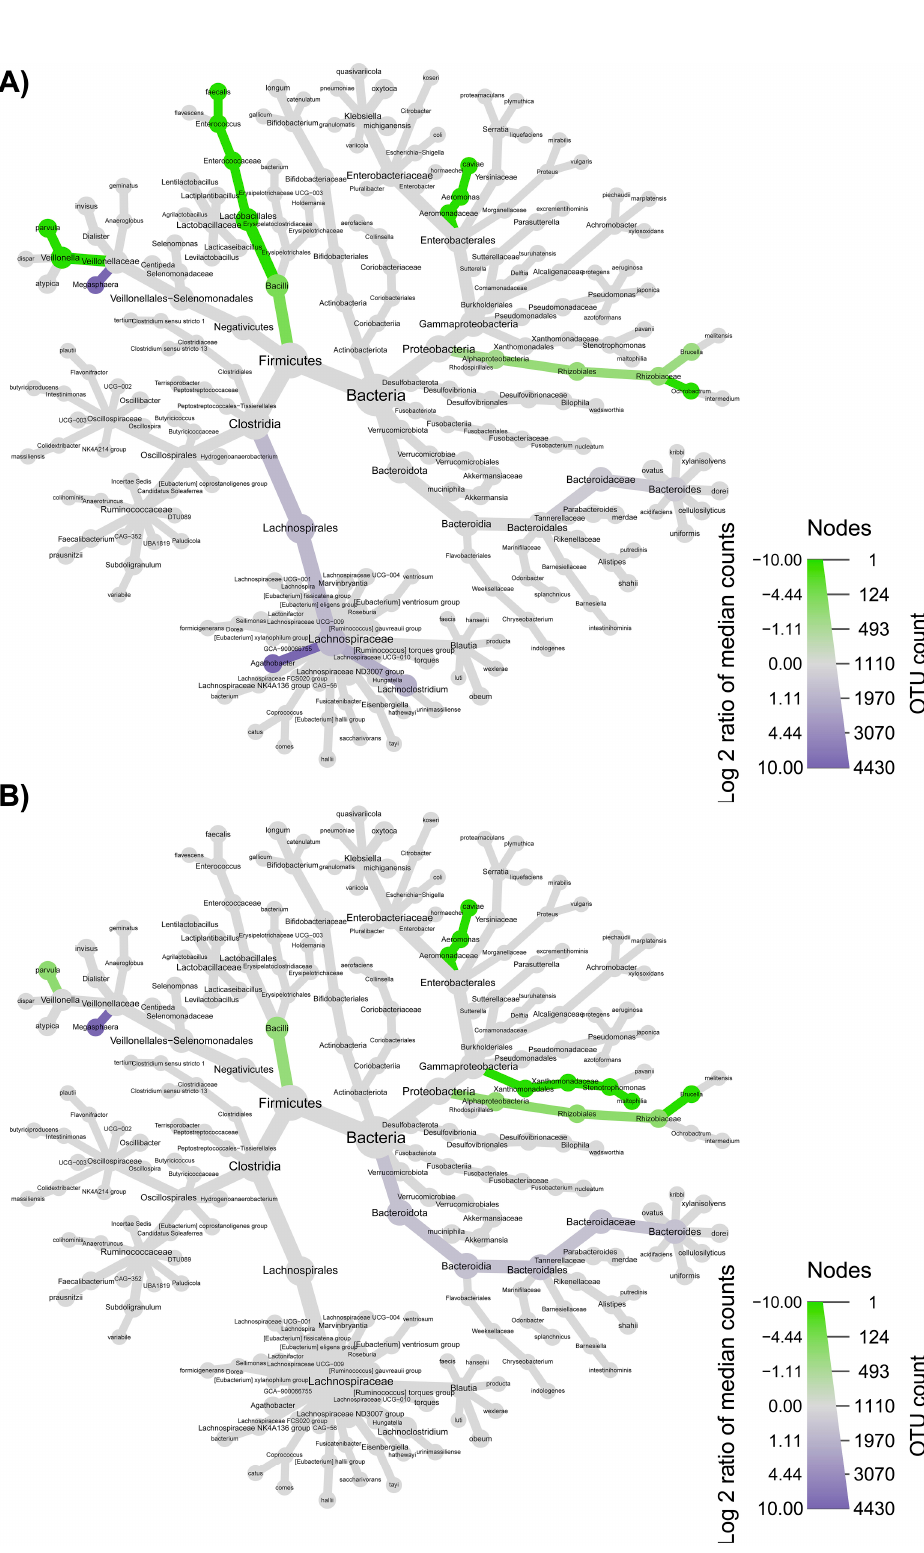
Figure 9. Microbial community taxonomic structure variations at different levels, before compared to after feeding with WB ( A ), and before feeding against the end of wash out period ( B ). Node size denotes the rarefied ASV count, and colored nodes indicate a significant ( p < 0.05) fold change for a given taxon: green color means that the taxon is differentially abundant before the treatment, while purple color indicates that the taxon is differentially abundant after feeding ( A ) or after wash out period ( B ). Color intensity is proportional to the fold